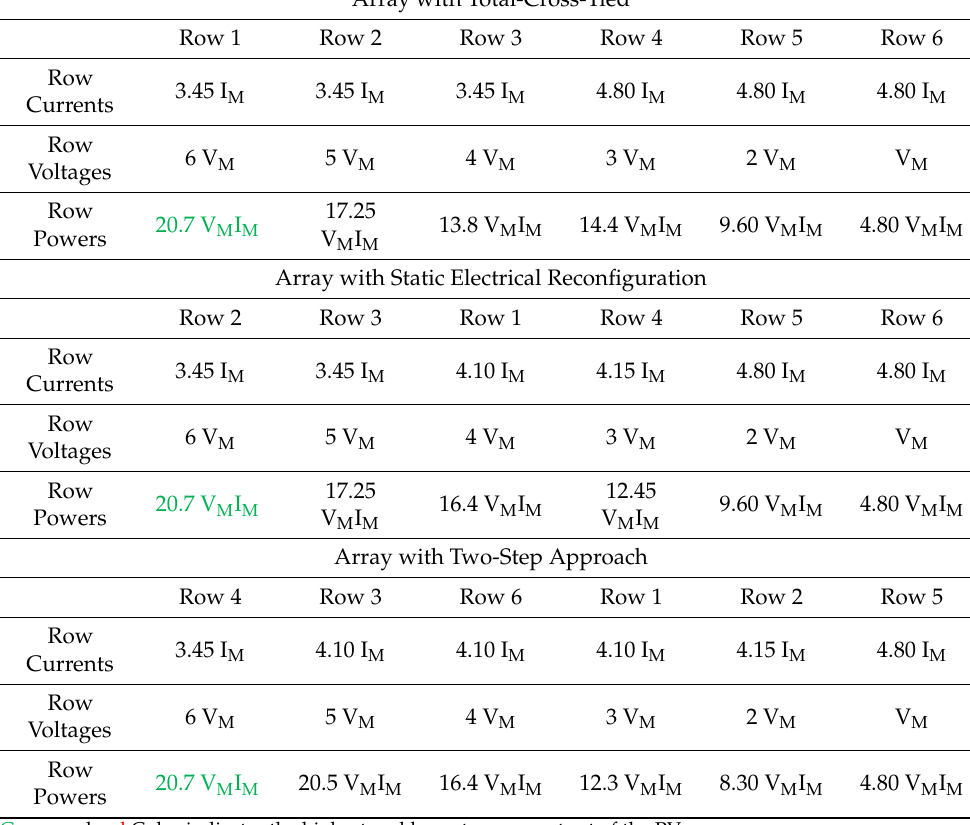
Table 1. Summarized mathematical estimation of the current, voltage and power values of the PV array under partial shading S1. Array with Total-Cross-Tied Row 1 Row 2 Row 3 Row 4 Row 5 Row